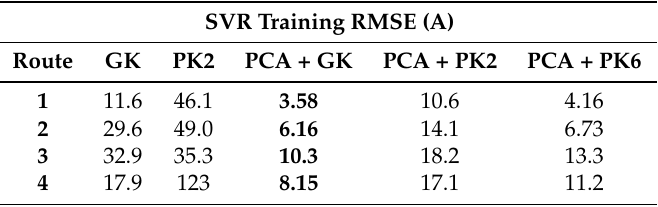
Table 2. RMSE (root mean square error) of SVR training for GK, PK2, PCA + GK, PCA + PK2 and PCA + PK6